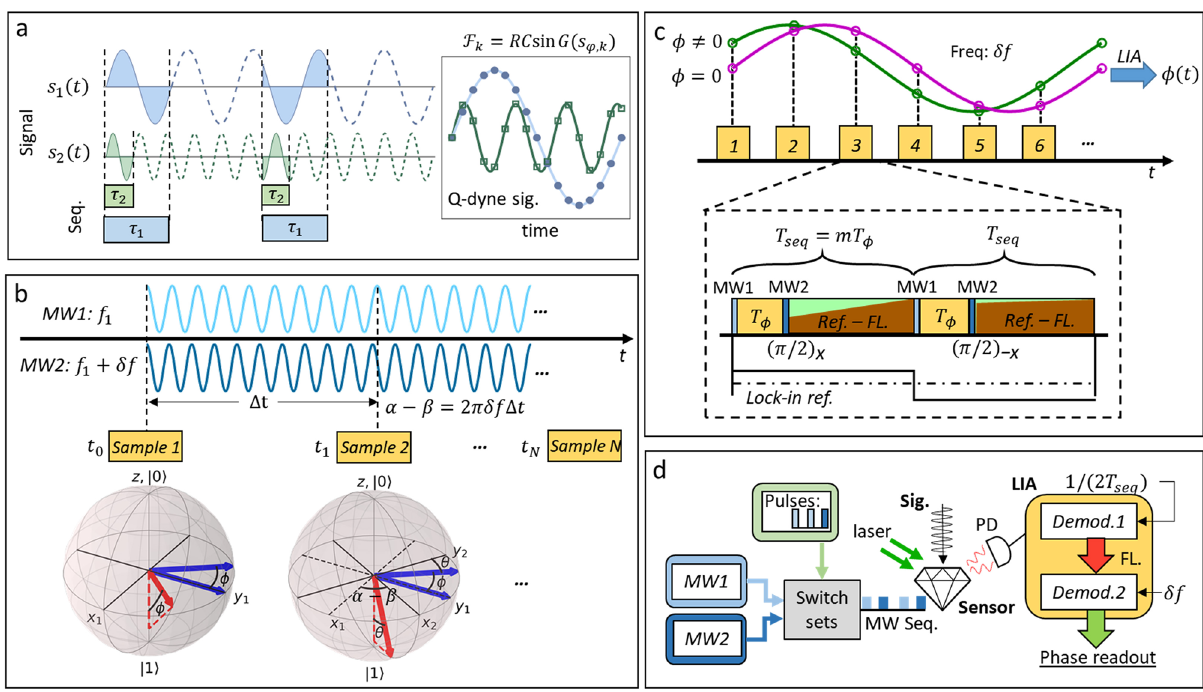
phase during the sensing interval. The acquired quantum phase is θ = 2 πδ f Δ t − ϕ at sample 2. Both the red vectors are the fi nal states of the two samples, and the projections are acquired as the curves in c , where we present the measurements when ϕ = 0 and ϕ ≠ 0. The phase factor ϕ can be extracted byalock-inampli fi er.Measurementsequenceisshowninthe dashed box. T ϕ is the fi eld interaction time, during which pulses are applied using MW1 The light and dark blue blocks are the π /2 pulses used for the interferometry and the dark blue pulses use MW2. The green and red represent the acquisition win- dows, in which the green is the laser reference and the red is the fl uoresces. m ≥ 2 is an integer. d Schematic of T seq is the length of each sequence part and the experiment. NV centers ensemble in diamond is used to perform the QPSD